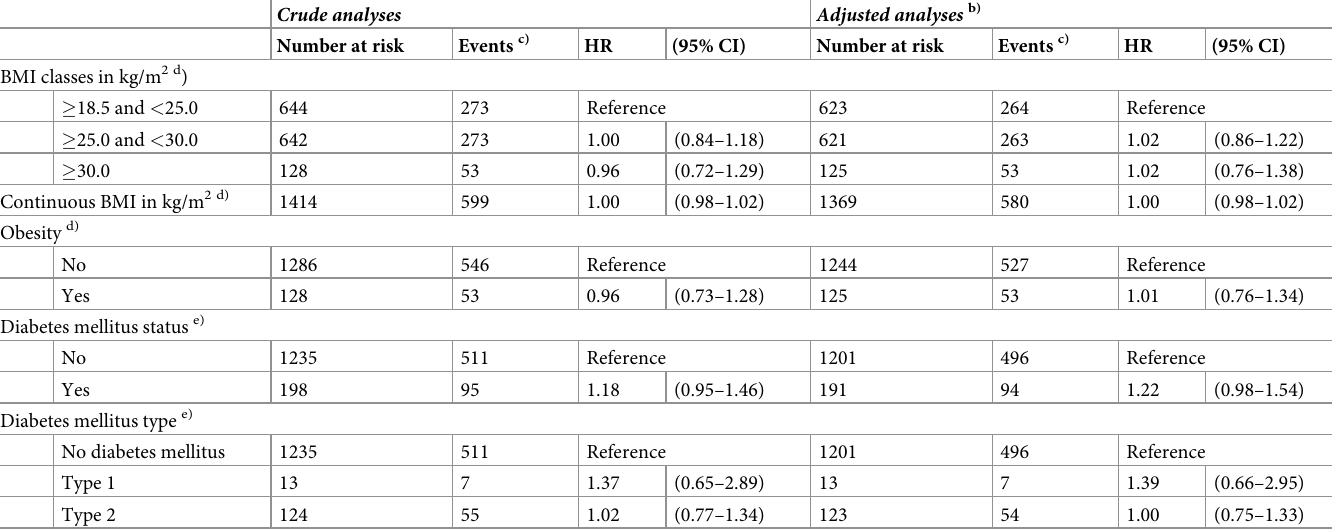
Table 2. Crude and adjusted hazard ratios (HR) with corresponding 95% confidence intervals (CI) for the associations of adult BMI and diabetes mellitus with risk of recurrence a) among non-muscle invasive bladder cancer